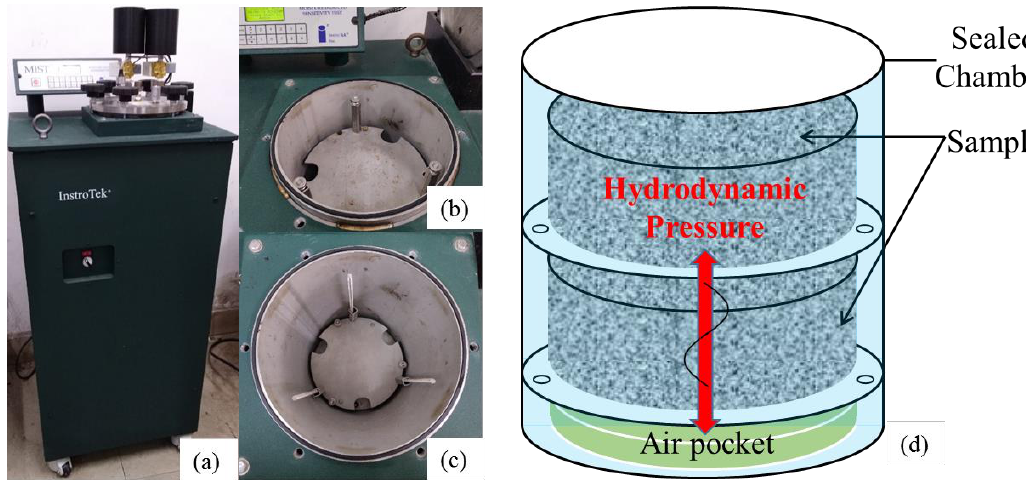
Figure 5. ( a ) Moisture induced stress tester (MIST); ( b ) top tray; ( c ) bottom tray; and ( d ) internal structure, with samples being treated.